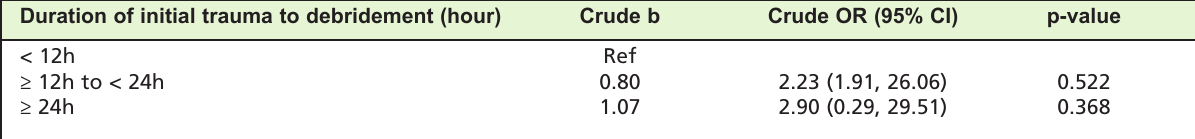
Table V: Binary logistic regression analysis to determine association between time to debridement and infection (based on positive micro-organism